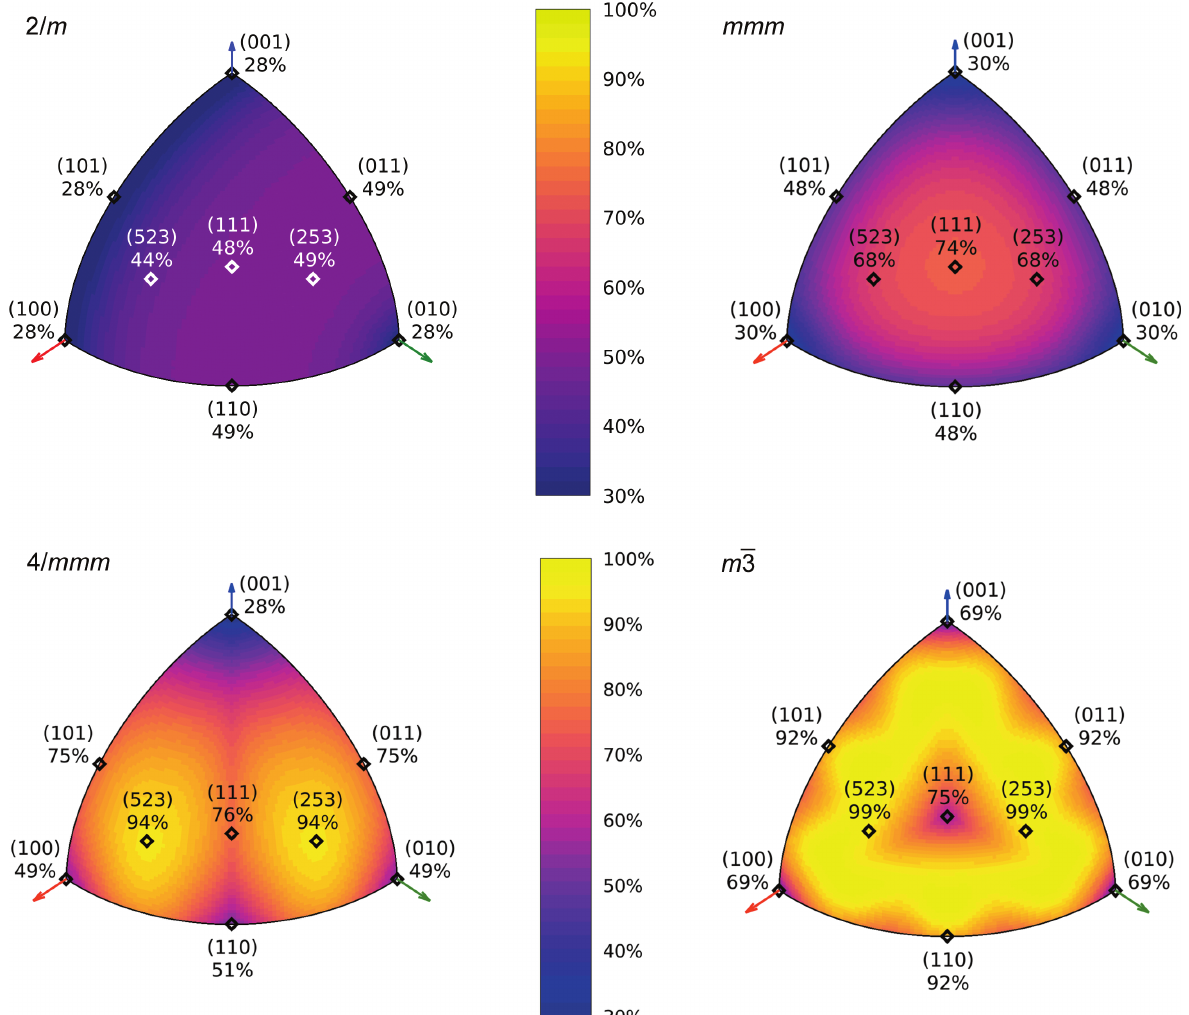
Figure 6 Potency heat maps for selected Laue classes, assuming the most common combination of (cid:2) = 35 (cid:2) and resolution limit of sin (cid:2) / (cid:5) = 0.6 A˚ (cid:3) 1 . Unit-cell parameters for tetragonal: a = b = 15 A˚ , c = 20 A˚ ; for other crystal systems: a = b = c = 20 A˚ . Potency as a function of sample orientation is mapped onto an octant of a unit sphere. Each point corresponds to normalized indices of a reciprocal space vector perpendicular to the DAC culet surface. Red, green and blue vectors represent x *, y * and z *, respectively. Examples of culet-perpendicular planes and resulting potency have been labeled and marked on the map using hollow